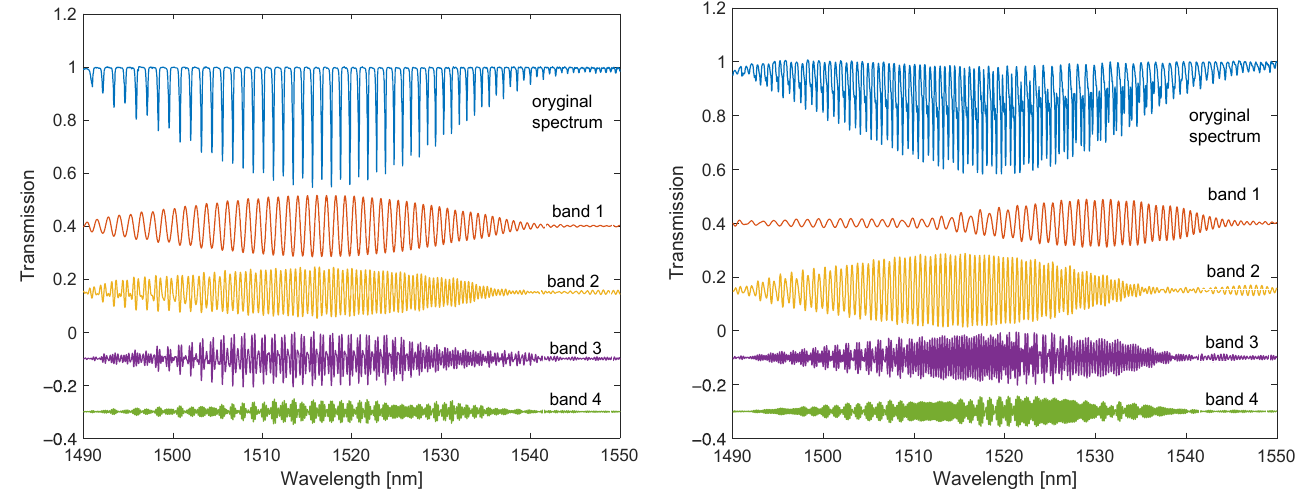
Figure 9. Optical spectra: original and band-filtered for individual frequency ranges for the TFBG and DC-TFBG (SRI = 1.333).